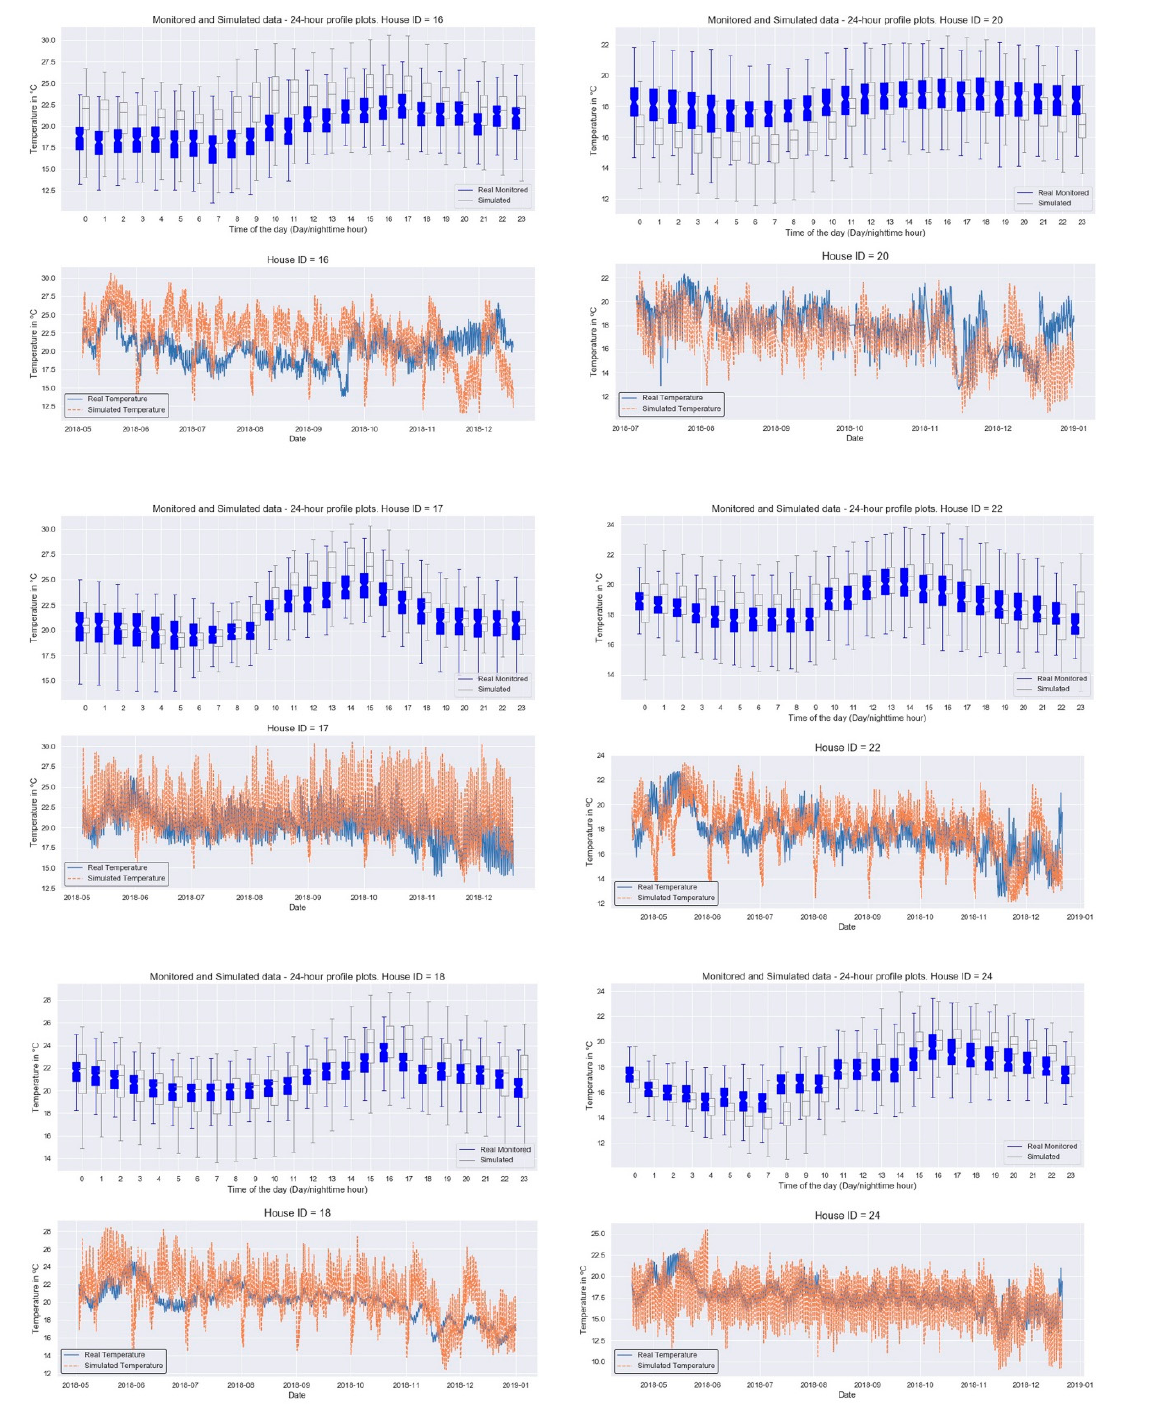
Figure A2. Results of the calibration of the models used for simulation—page 2.